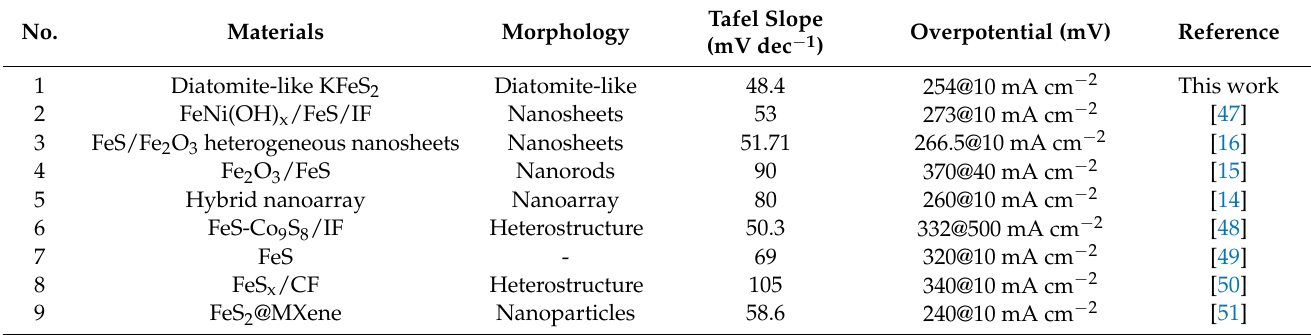
Table 2. Various iron-based sulfide electrode materials with their Tafel slopes and